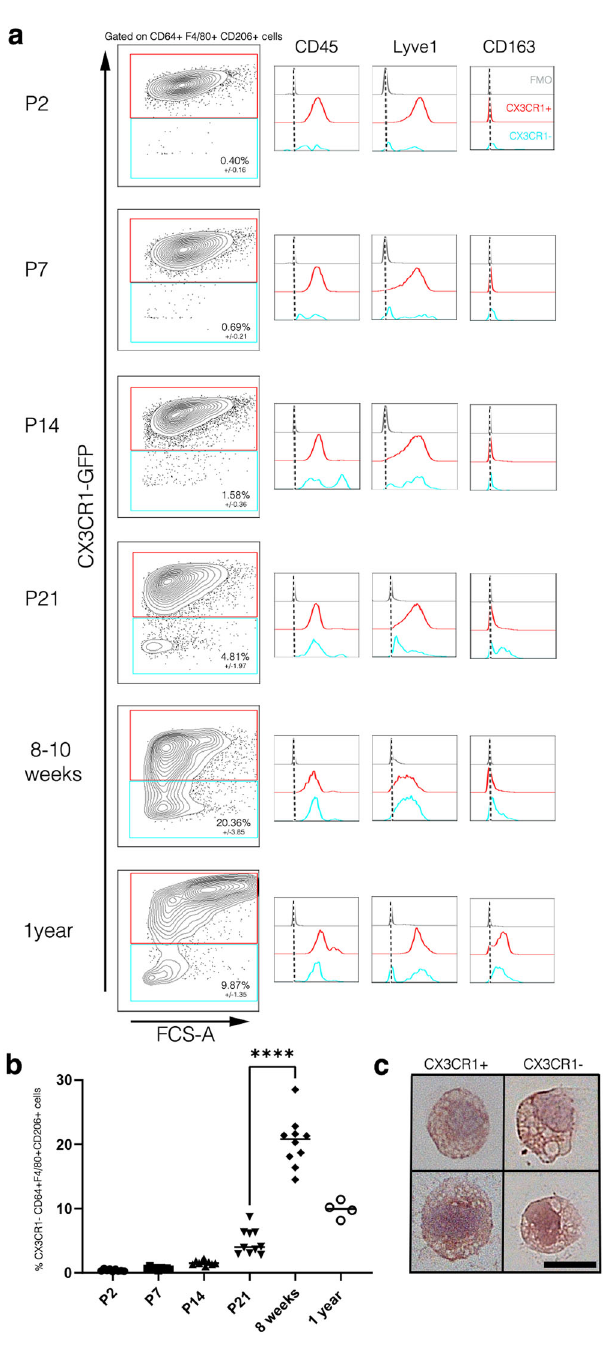
Fig. 2 | Perivascular Lyve1 + celllocation. a 200 µ m Maximum intensity projection of a lightsheet microscope acquisition of the cortex at the dorsal side in a cleared mouse brain labeled for SMA (green), CD31 (red), and Lyve1 (blue) ( n =2). b Confocal microscopy of brain sections stained for podoplanin (green), Lyve1 (red), and CD31 (blue) ( n =4), inserts ( c ) and d zoom in on Lyve1 + cells lining the blood vessels and placed outside of the « cul-de-sac of the pia mater » de fi ned by the podoplanin labeling. e Confocal microscopy of a dorsal cortex section stained for CD31 (green), laminin- γ 1 (red), and Lyve1 (blue) ( n =3) with insert ( f ) showing a higher magni fi cation showing the Lyve1 + cells in the perivascular space ( n =2). g 55 µ mcryosectionofthe Cx3cr1 GFP braincortex,withthelocationofLyve1 + (white) pvMs lining the blood vessel (CD31, blue) but within the perivascular space deli- neated by the laminin α 1 staining (red). h CX3XR1 – pvMs (red arrow), while i is a